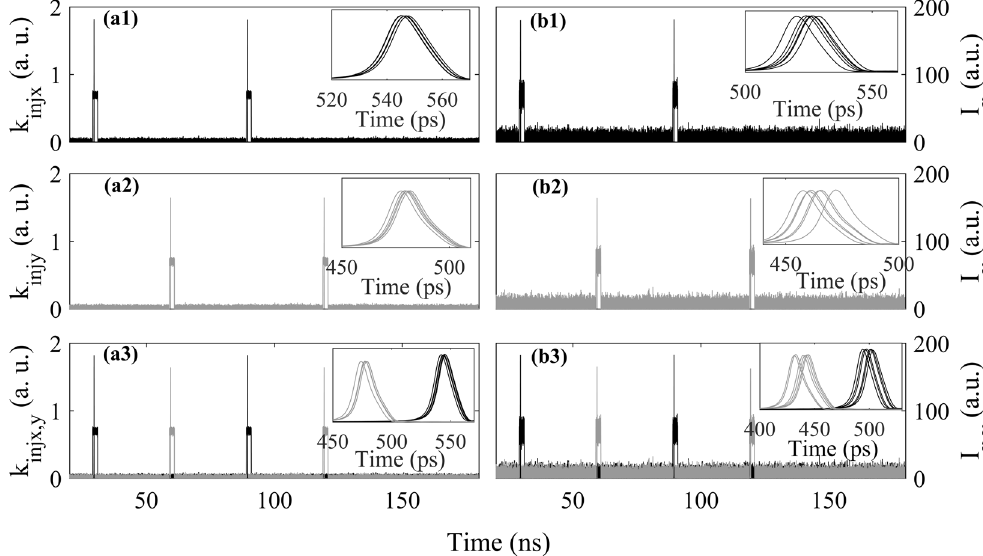
Figure 8. Numerical simulation of RZ bit sequence encoding in XP mode (( a1 ) and ( b1 )), YP mode (( a2 ) and ( b2 )), and both in XP and YP modes (( a3 ) and ( b3 )), when the RZ bit sequence has an SNR = 30 dB (( a1 )–( a3 )), SNR = 20 dB (( b1 )–( b3 )). Insets: eye diagrams corresponding to ( a1 )–( b3 ),